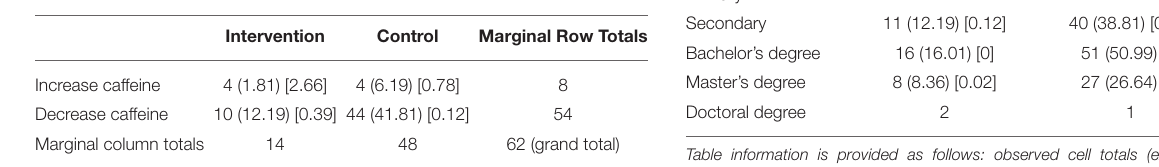
TABLE 6 | Sub-aim 2: participants with DTCGT may increase the caffeine intake, based on the knowledge about their caffeine metabolism (the p = 0.047. This result is significant at p < 0.05); however, the sample size is quite limited.